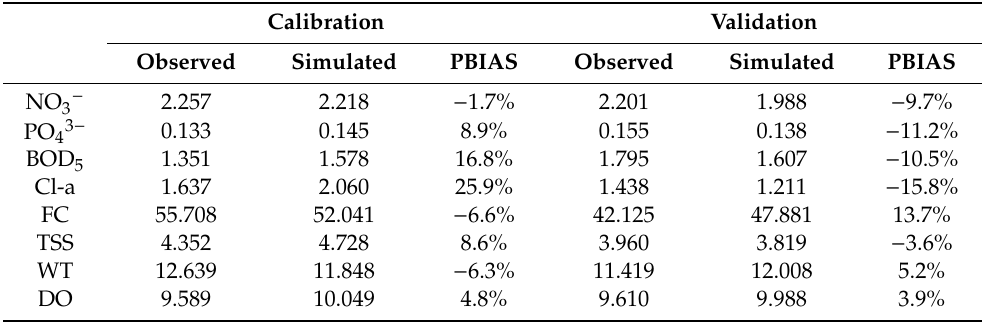
Table 2. Mean concentration values of water quality parameters for the calibration and validation period and respective relative bias (Percent Bias (PBIAS) in